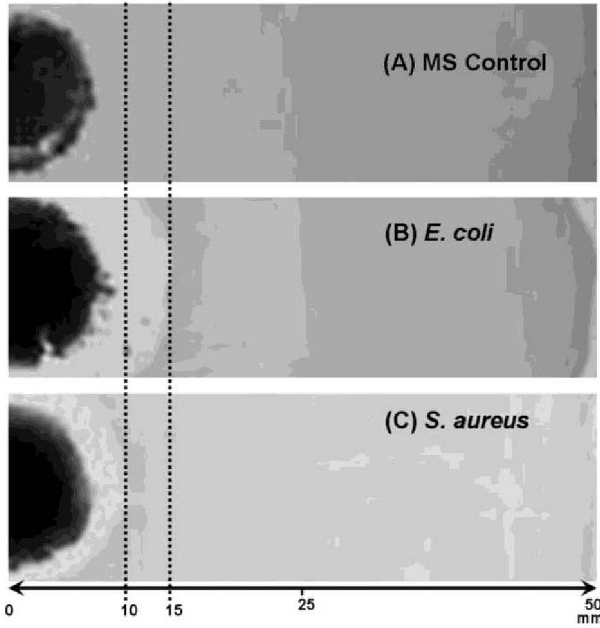
Figure 7. Representative photographs of agar growth plates for ( A ) S. aureus + MS control experiment; ( B ) S. aureus + MS/AgNP (0.180 mmol g −1 ); and ( C ) E. coli + MS/AgNP (0.180 mmol g −1 ) (Scale = 50